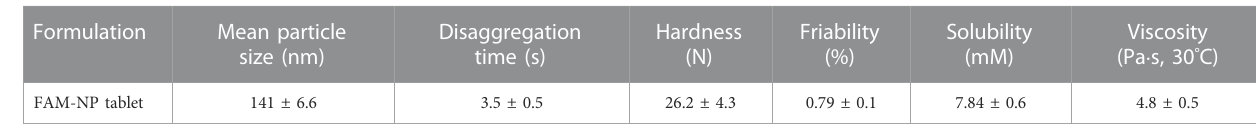
TABLE 2 Characteristics of the FAM-NP tablet after 3 months of